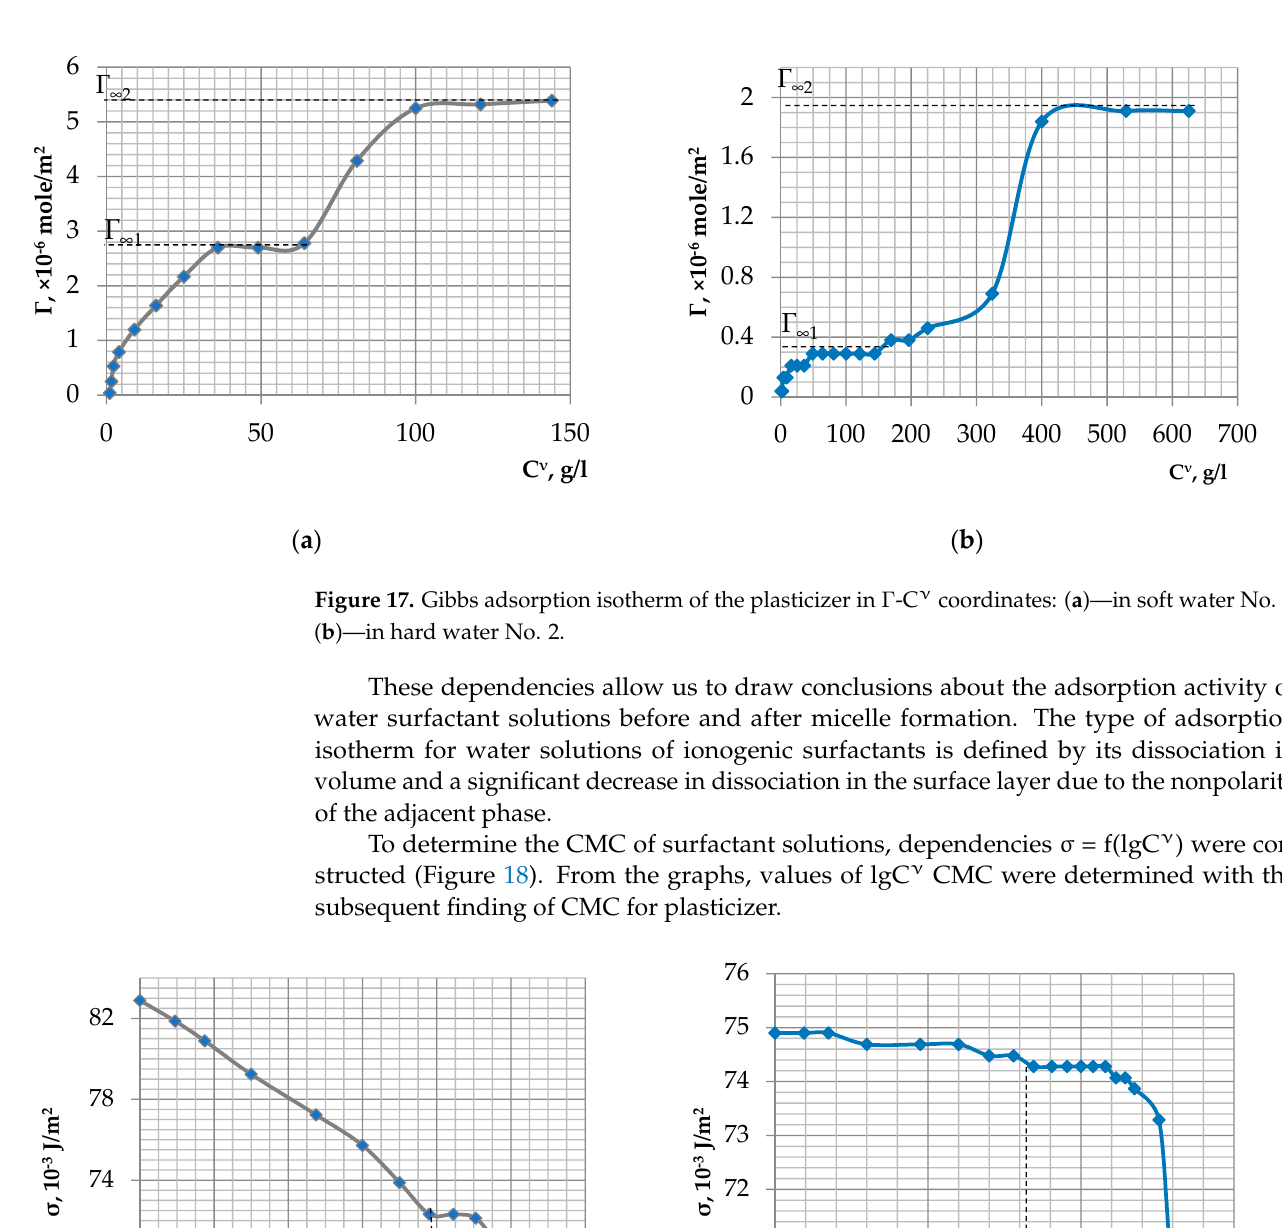
( b )—in hard water No. 2.